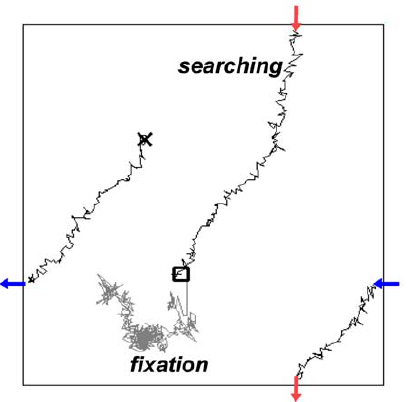
Figure 8. Searching and fixation by the present mechanism. First, a bump moves on the cortical field under noisy condition ( s noise ~ 19 : 0 pA). Its two-dimensional trajectory is indicated by the black line starting at ‘X’. This movement corresponds to the search in the retinotopically corresponding visual field if the visual cortex is considered. When something worth attending to (of which the retinal image is in the black square) is found, the transient global inhibition whose duration is 50 ms as in Figure 6A, immobilizes the bump around the region of interest, which corresponds to the fixation of visual attention. The two-dimensional trajectory after this transient input for 2500 ms shows its immobile nature (gray line). Note that the trajectories going outside from one sides of the field expressed by the outward arrows come in at the other sides expressed by the inward arrows of same color because of periodic boundary condition. In